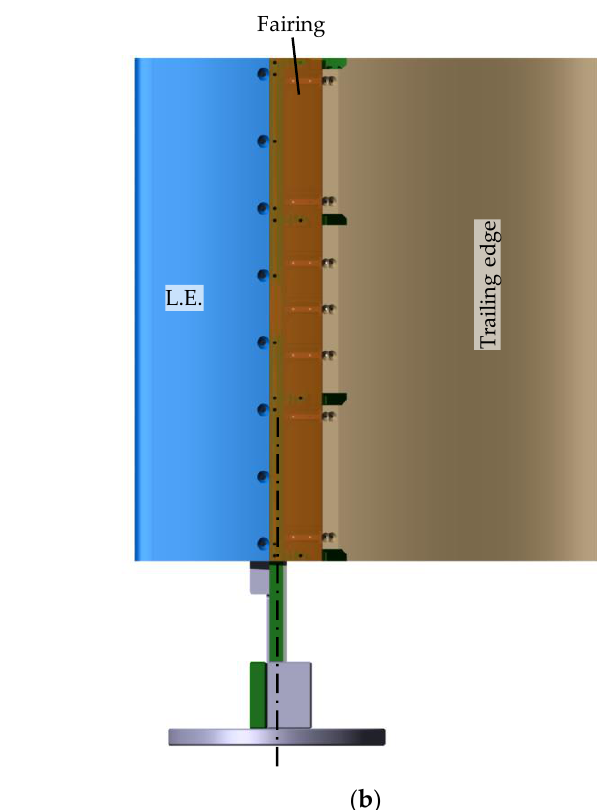
Figure 4. Trailing edge deformation for optimized structure (actuation input is limited within ±60°).